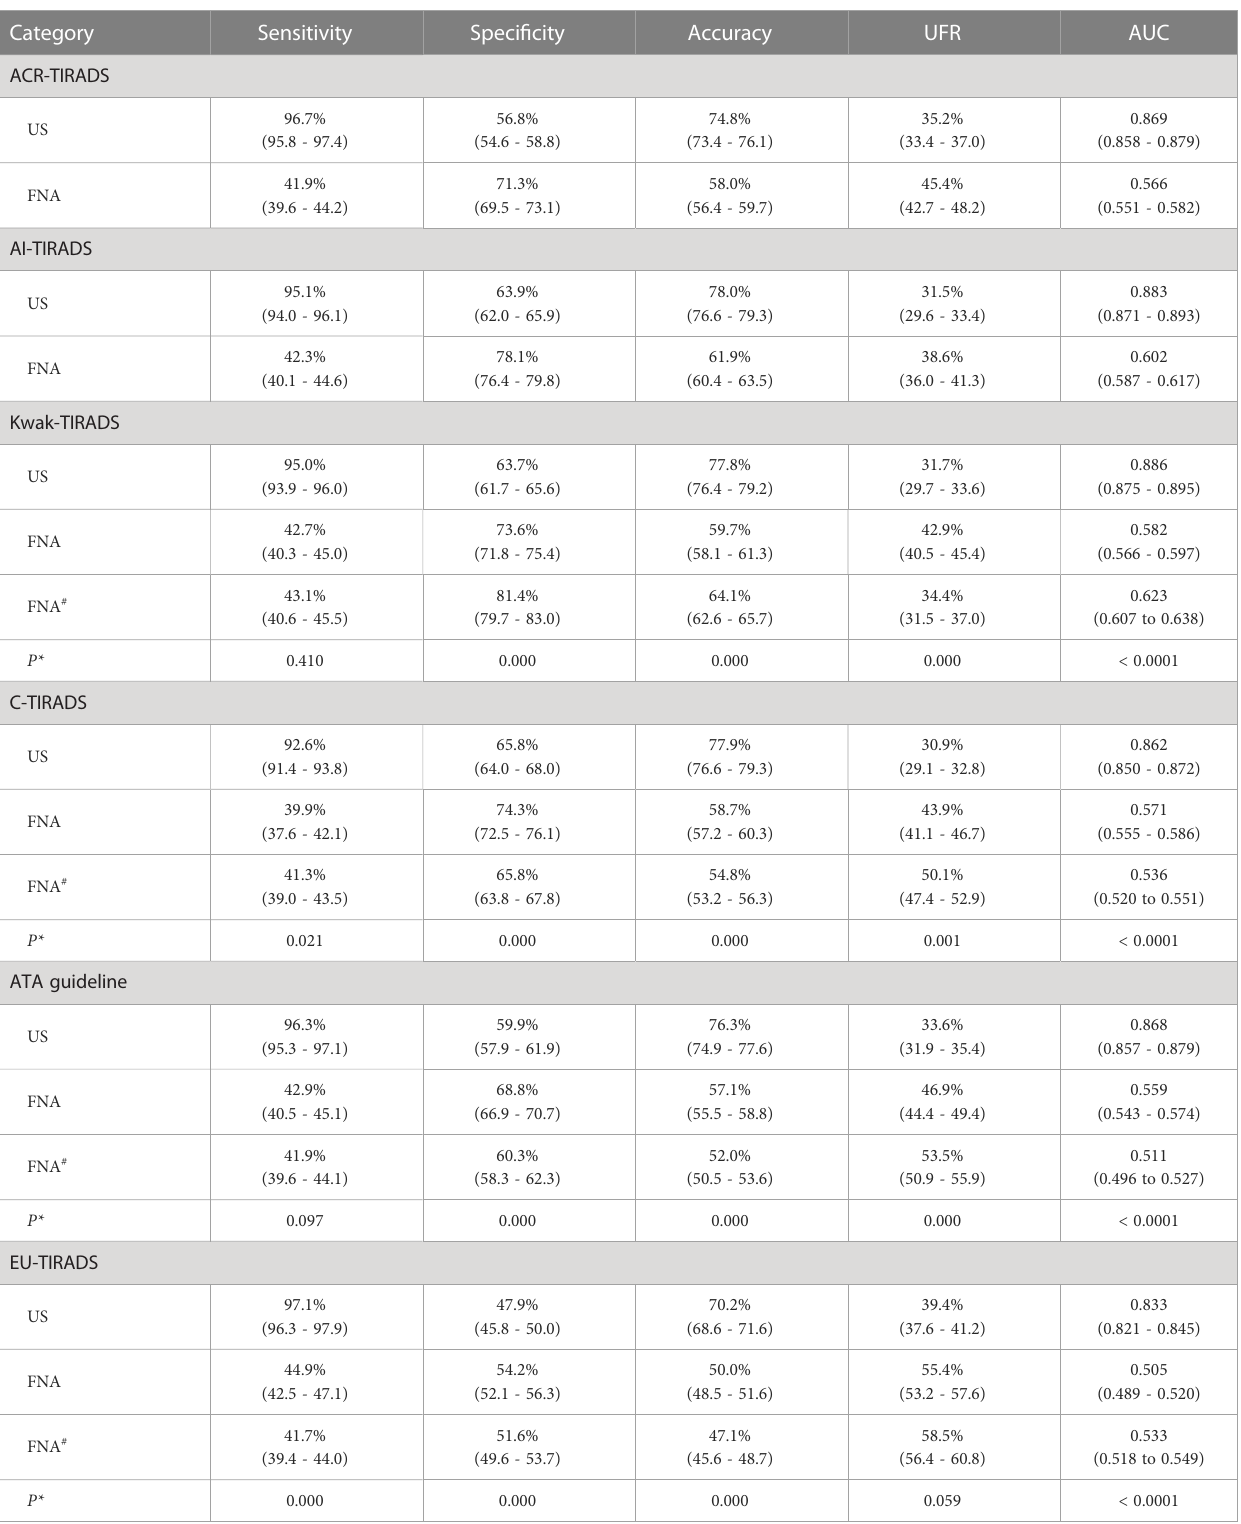
TABLE 3 Diagnostic performances according to the US-based fi nal assessment and FNA thresholds.